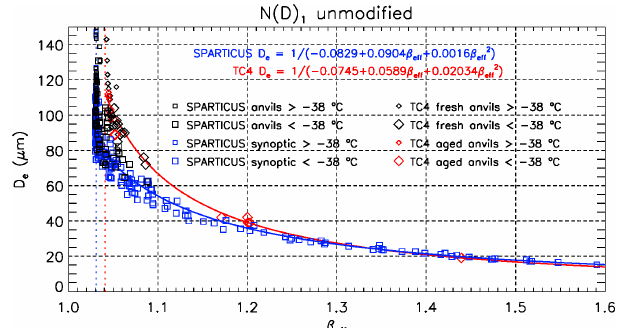
Figure 3. Dependence of the PSD effective diameter D e (µm) on the effective absorption optical depth ratio β eff as predicted from the method of Parol et al. (1991), based on PSDs from SPARTICUS synoptic cirrus (blue squares) and anvils (black squares), and TC4 aged (red diamonds) and fresh (black diamonds) anvils, where the first size bin is included ( N(D) 1 unmodified). The larger (smaller) symbols denote PSDs measured at a temperature colder (warmer) than − 38 ◦ C. The curve-fit equations give 1 /D e in µm − 1 ; they are for SPARTICUS synoptic cirrus (blue) and for TC4 aged and fresh anvils